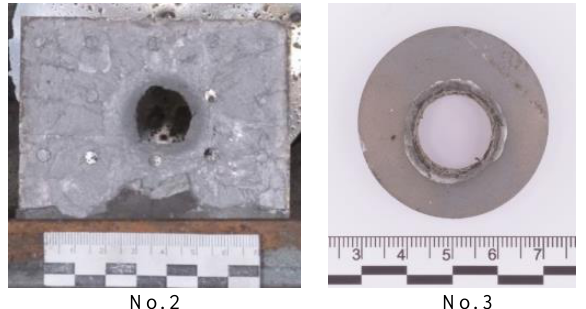
Fig 6. Photographic record of the sample No. 1 Al 2 O 3 break through